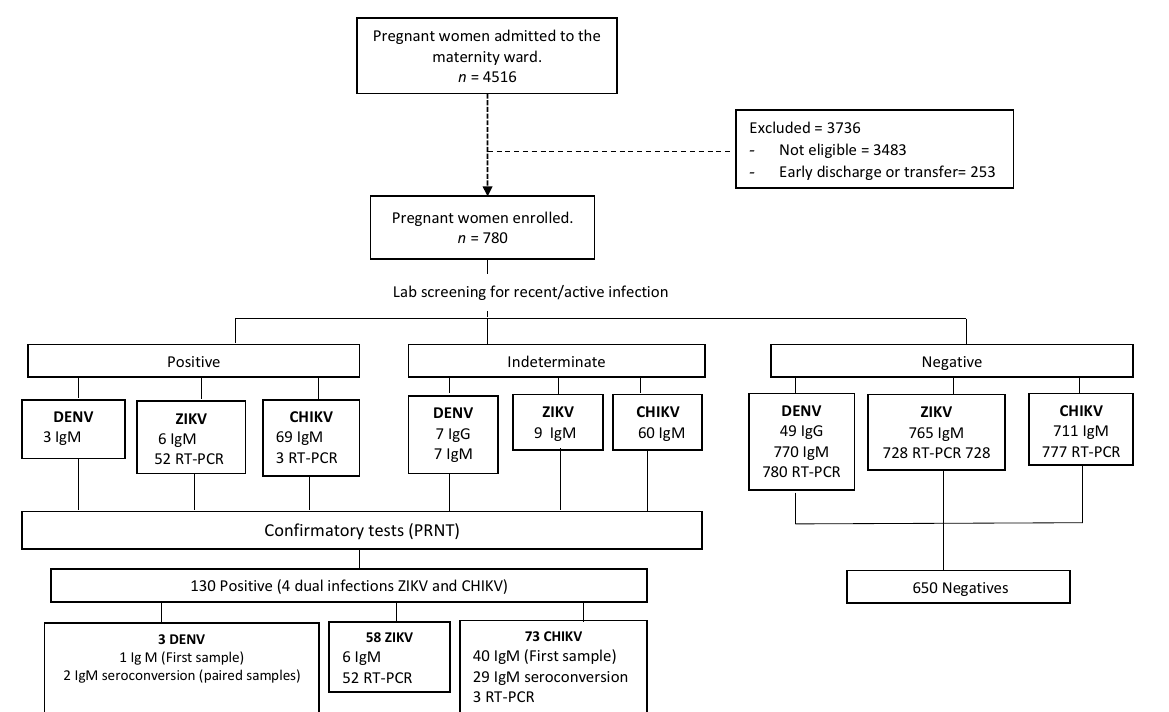
Figure 1. Flowchart of the study population.